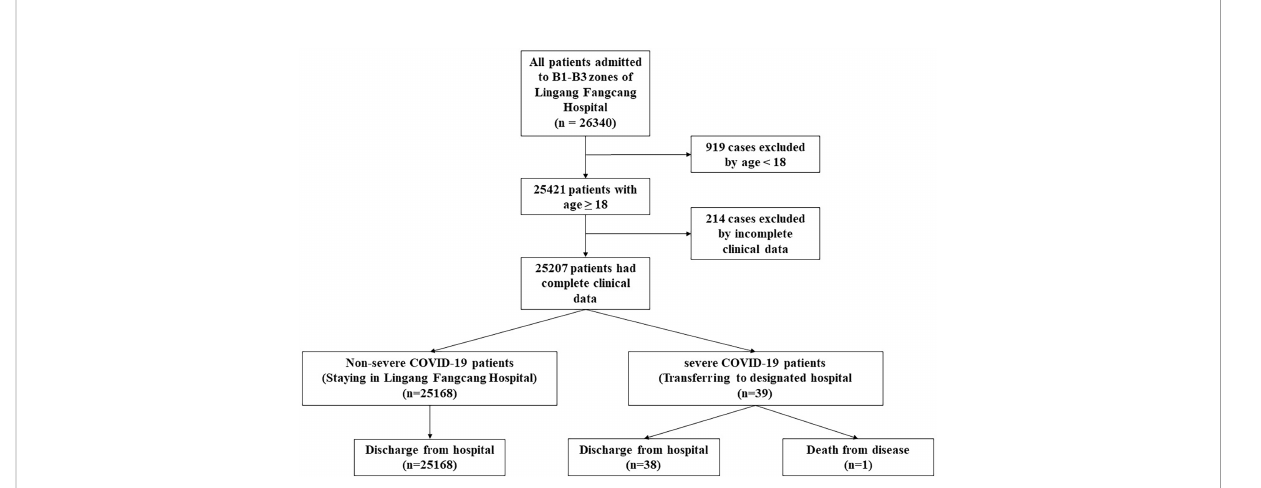
FIGURE 1 The fl owchart of COVID-19 patients admitted to Lingang Fangcang